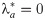
The optimal strategy for the two phenotypes case.The optimal fraction of the strategy with non-zero lag time x* (A and B) and the optimal lag times of both two strategies (λa*=0 and λb*) and the one strategy case (λ*) (C and D) are plotted against the antibiotics application time T for different probability of the antibiotics application p. In A and B x* (circles) and xL* (filled points) represents the globally and locally optimal fraction, respectively. In C and D, the optimal lag time of the phenotype is plotted only if its globally optimal fraction in the population is non-zero because any value is allowed as the optimal if the fraction is zero. p = 0.2 for A and C, and 0.8 for B and D. γ is set to unity.